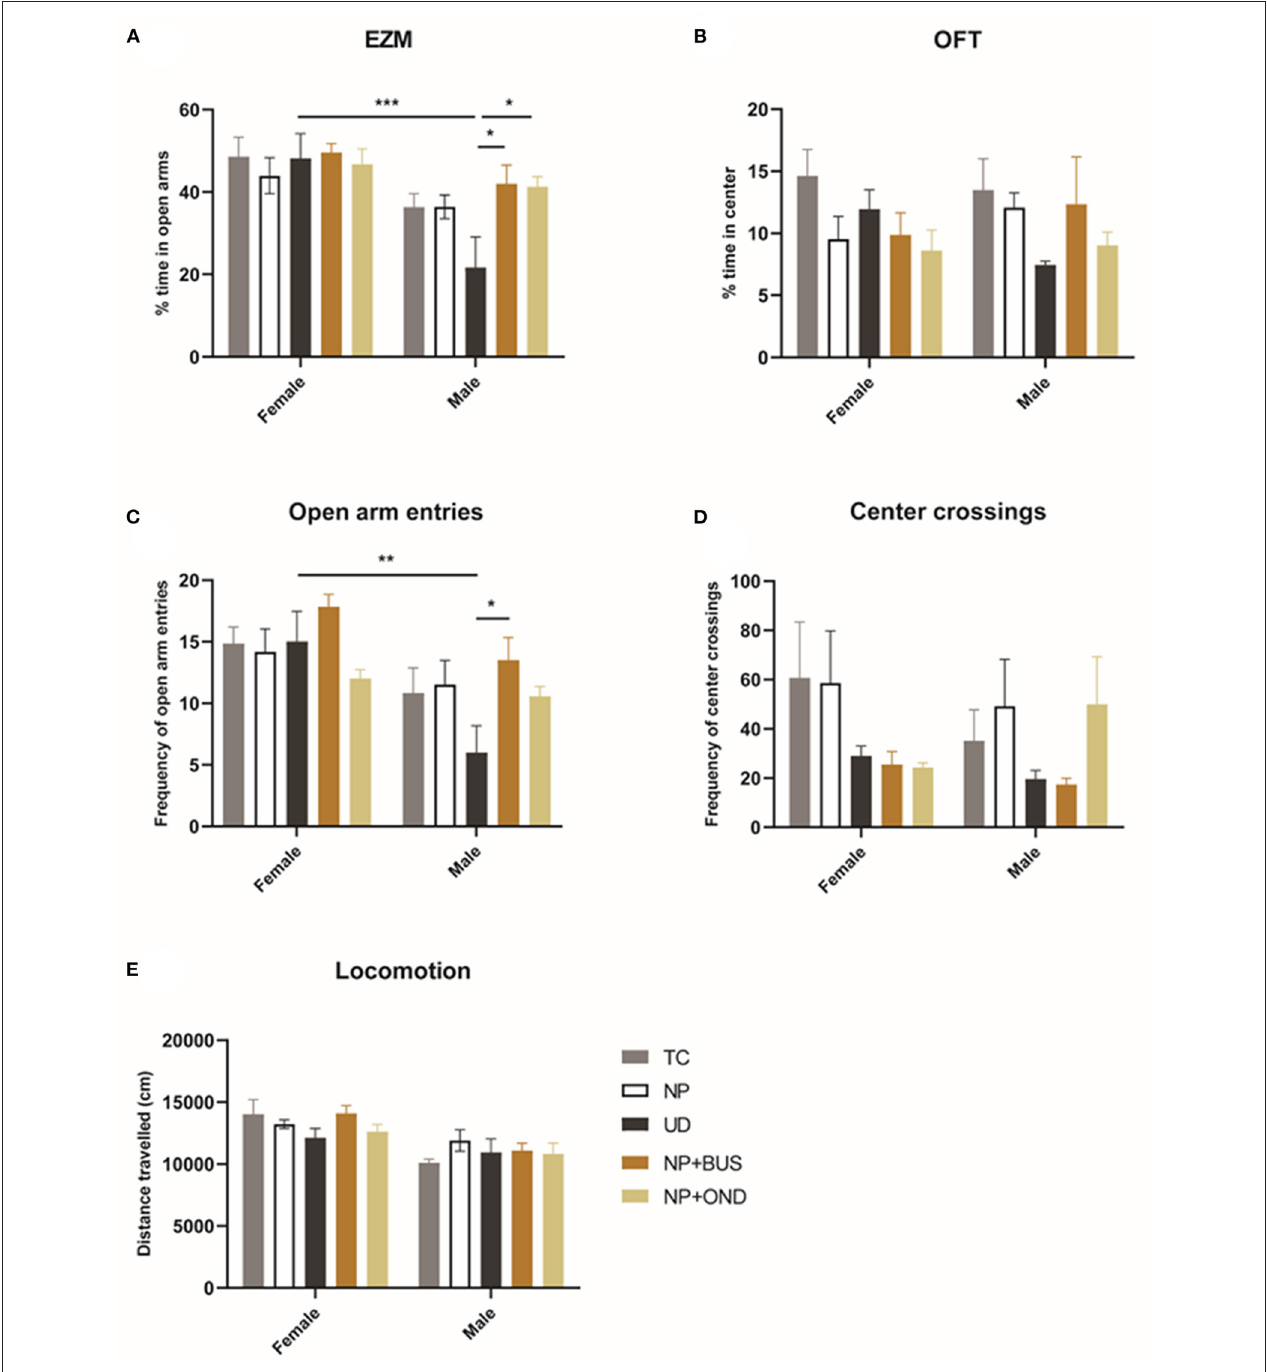
FIGURE 6 | Neonatal conditions and adult anxiety behavior. (A) The percentage of time spend in the anxio-genic (open arm) region of the elevated zero maze (EZM) showed a significant difference between males and females [F (1, 49) = 19.75; p < 0.01]. No differences between conditions are observed in females, whereas UD males spend significant less time in the open arms as compared to all other neonatal conditions [F (4, 25) = 3.545; p = 0.0201]. (B) The percentage of time spend in the anxio-genic (center) region of the open field test (OFT) is not influenced by sex or condition. (C) The frequency of open arm entries is significantly affected by condition [F (4, 49) = 2.788; p = 0.0365] and sex [F (2, 49) = 16.62; p < 0.01]. UD animals exhibit significantly less open arm entries as compared to NP + BUS animals in males only. (D) The number of center crossings in the OFT is not affected by sex [F (1, 19) = 0.3304; p = 0.5681] or condition [F (4, 49) = 0.8757; p = 0.4853]. (E) Locomotor activity significantly differs between males and females [F (1, 49) = 21.20, p < 0.01] but is unaffected by condition [F (4, 49) = 1.177; p = 0.3325]. NP, needle prick animals; NP + OND, needle prick animals receiving ondansetron; NP + BUS, needle prick animals receiving buspirone; TC, tactile stimulation animals; UD, undisturbed control animals. Data is presented as mean ± SEM, * P < 0.05, ** P < 0.01, *** P < 0.001.